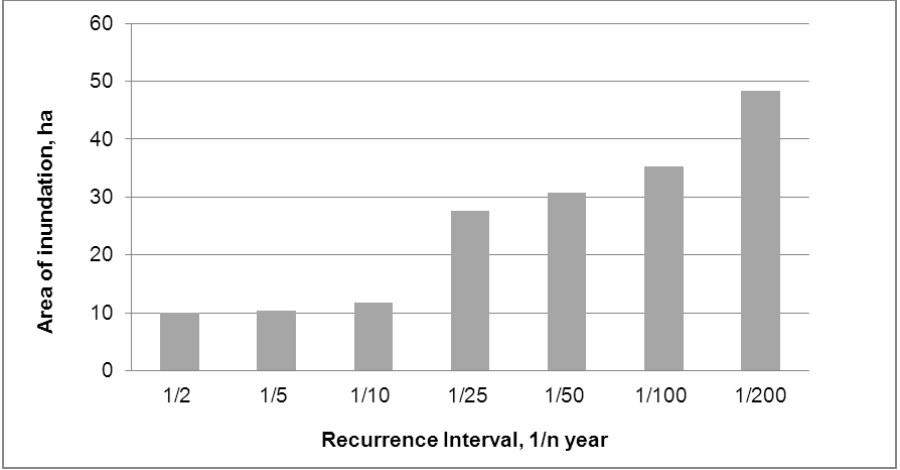
Figure 8. Flood inundation area under different recurrence interval storm